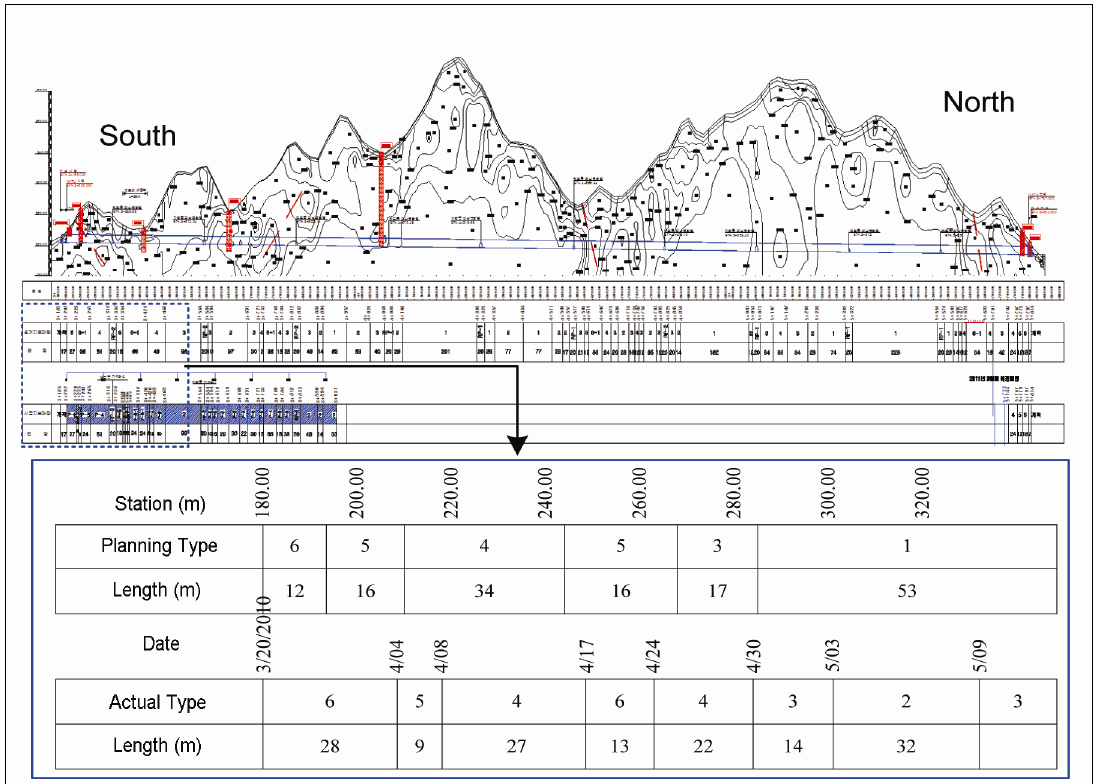
Fig. 1. An example project management schedule for a tunnel